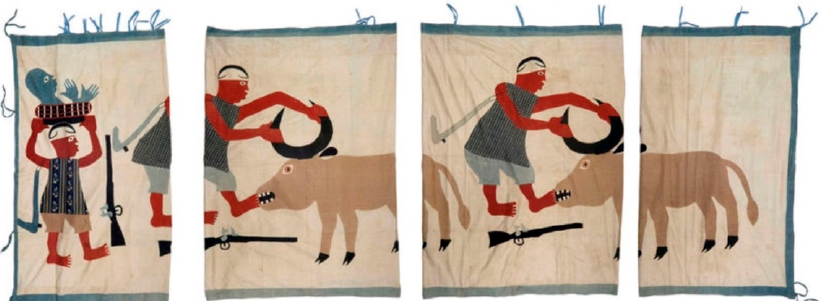
Figure 12. This flag, of appliqued cloth, silk and cotton, was among the gifts collected by Régis agents in Dahomey in 1856 for Napoleon III. It may have been the product of the workshop of Hantan et Zinflou families. Musée du Quai Branly’s caption says that “this scene represents the exploits of the young Prince Gakpe, future King Ghezo, seizing a buffalo with his hands, the origin of his epithet (nom fort) and his principal emblem, the buffalo”. Considered one of the fiercest animals in Africa, they are responsible for the deaths of hundreds every year. The connections between African kings and animals are common both in origin stories and epics like Sundiata with its fantastic stories of shape-shifters, hunters, sorcerers and diviners, and in royal art depicting a ruler in terms of the strength, agility, wit, or violence against adversaries. In one account “a buffalo left the forest, entered Abomey and stirred up panic. Only Gezo had the courage to meet it; tak-ingit up by a horn, he turned it over and trampled it to death” (Adams 1980, p. 36). A figure on the left, carrying a decapitated person overhead, is wearing shorts and a vest made of Provençal cloth, with vertical stripes alternating with small flowers. Similar cloth can still be found in shops in France today. Image courtesy of the Musée du Quai Branly.